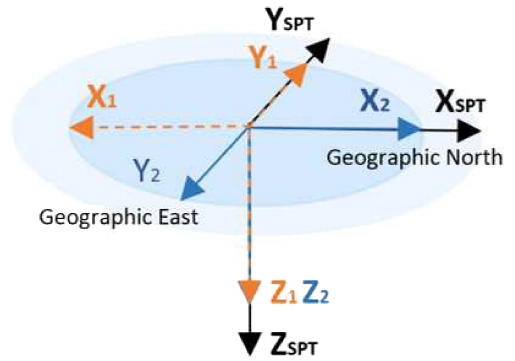
Figure 12. Relative axes of MOURA: X1, Y1, Z1 and X2, Y2, Z2 and SPT Observatory: XSPT, YSPT and ZSPT.